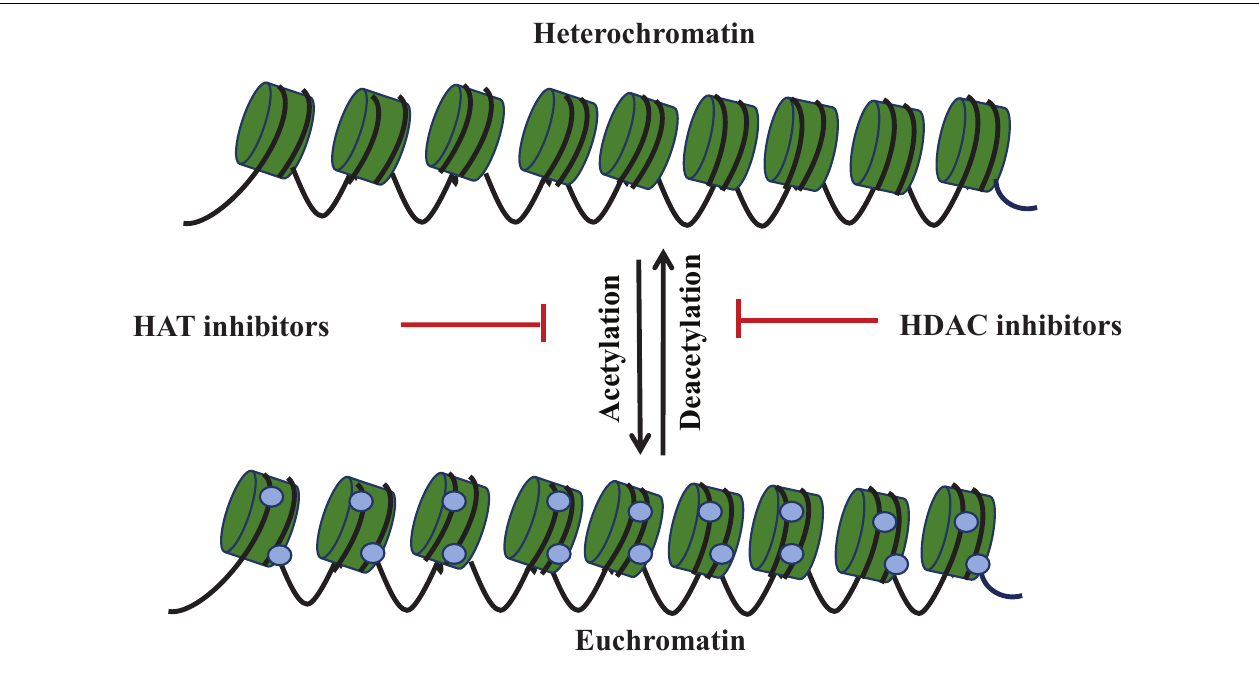
FIGURE 4 | Epigenetic modulation showing histone acetylation mediated by histone acetyltransferase (HAT) and deacetylation mediated by histone deacetylase (HDAC). HDAC inhibitors activate the silent gene by inhibiting the histone deacetylase. These labels are associated with chromatin modulation required for cryptic gene